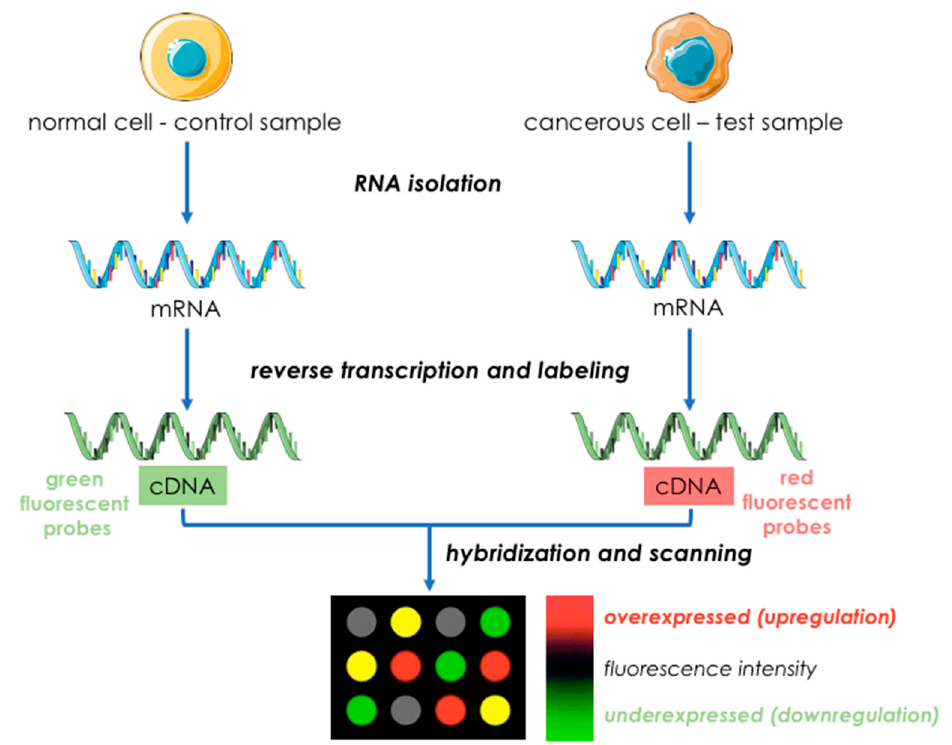
Figure 2. An overview of DNA microarray technology (based on [47]). This figure was created using images from Servier Medical Art (http://smart.servier.com). Servier Medical Art by Servier is licensed under a Creative Commons Attribution 3.0 Unported License.